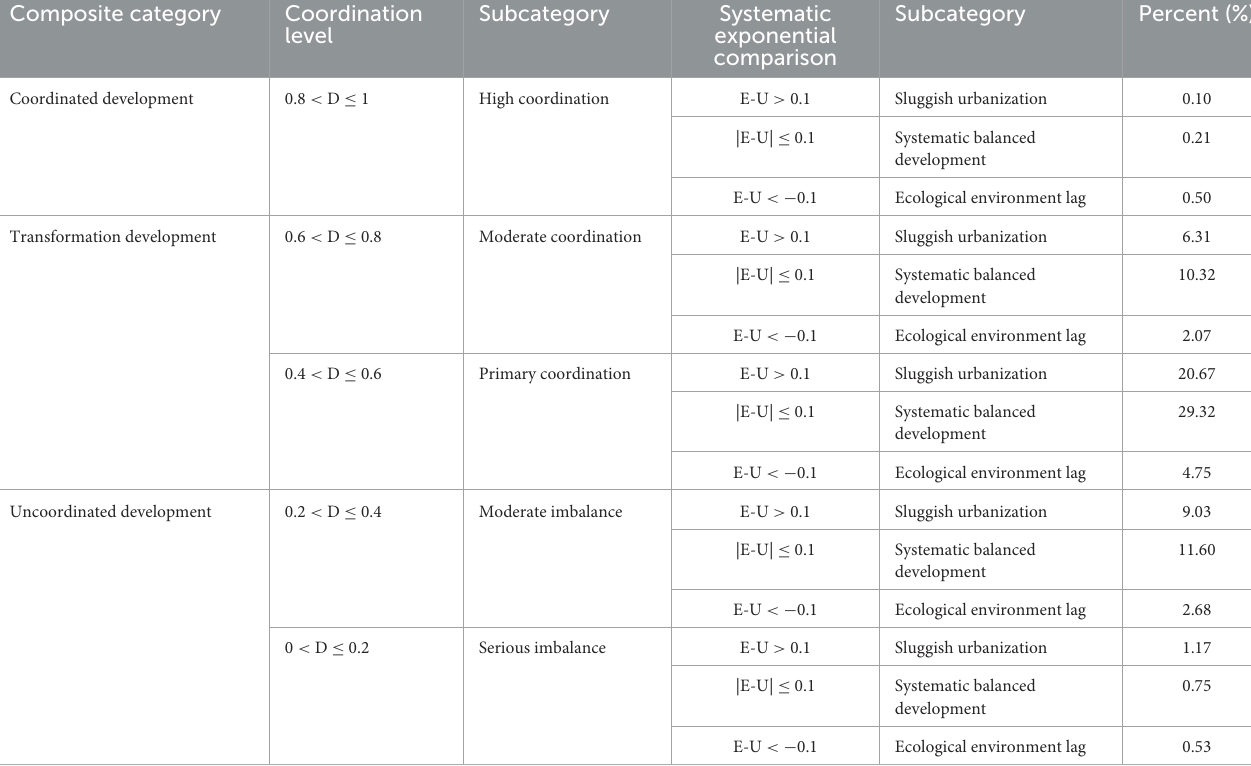
TABLE 4 Classification categories for the coupling coordination of urbanization and the ecological